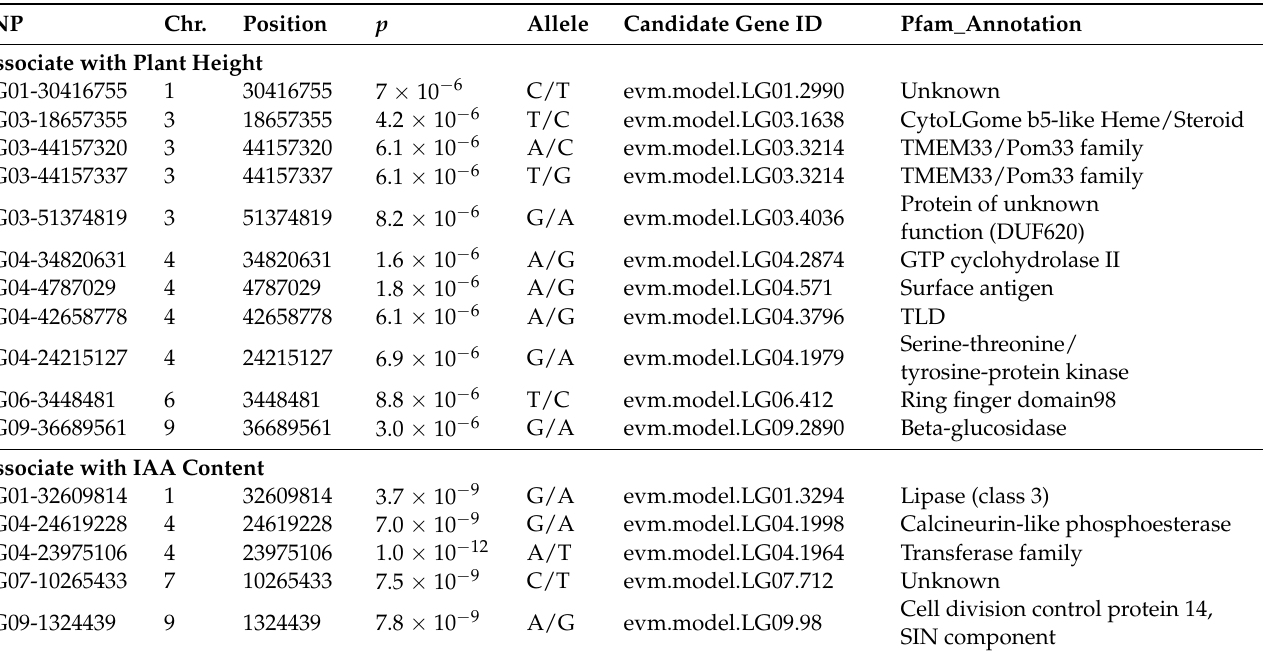
Figure 2. Genome-wide association study of phenotypic trait with SNPs. Manhattan plot shows association signals with ( a ) plant height and ( b ) IAA content. The blue lines show the threshold, and the red point represents the significant signals with the corresponding trait. The outermost circle indicates the SNP density. Table 1. SNPs were significantly associated with plant height and IAA content, and a subset of candidate genes was